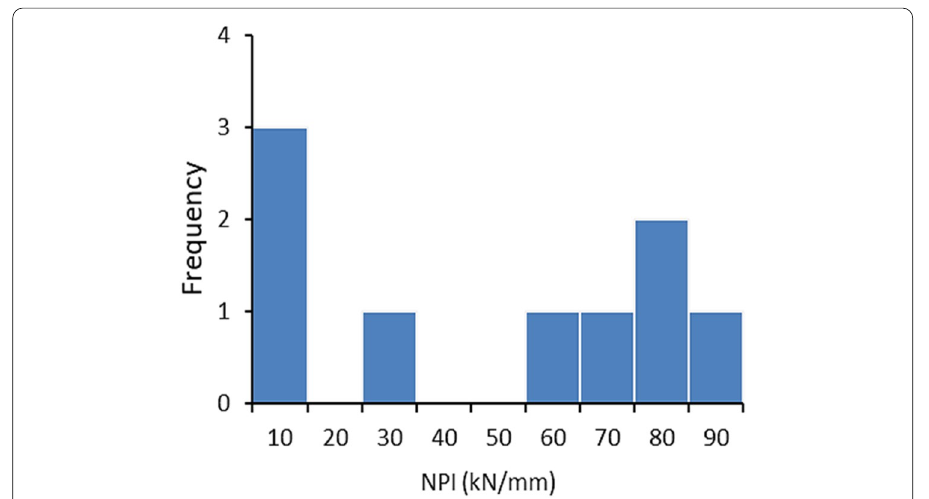
Fig. 15 Histogram plot for the NPI values